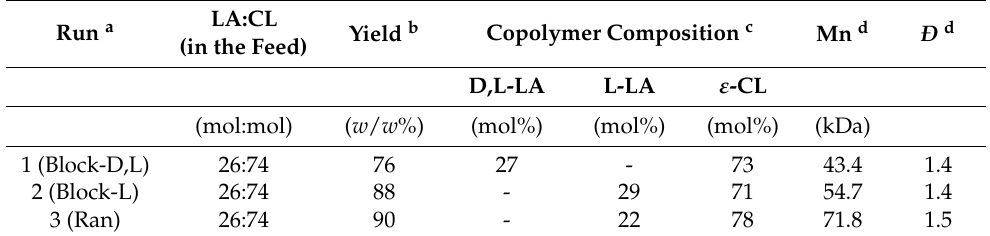
Table 1. Copolymerization of caprolactone and lactides catalyzed by complex I.